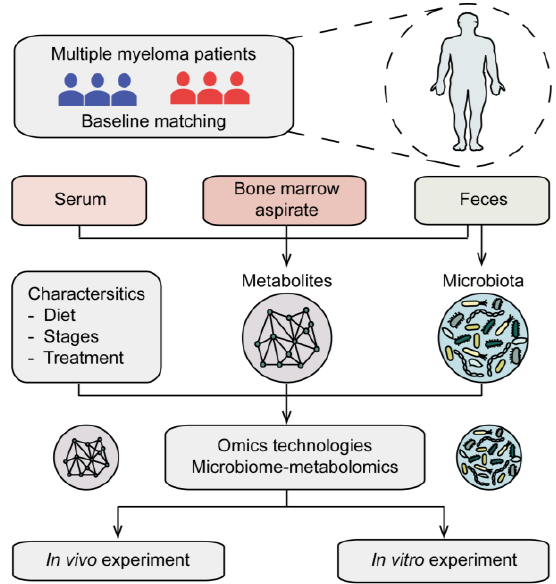
Figure 2. Application of microbiome/metabolomics in multiple myeloma. Eligible MM cohorts with matched baselines are recruited for sampling, then collected along with clinical characteristics for further analysis. Samples of serum, bone marrow aspirate and feces are performed with metabolomics, while paired fecal samples are utilized for microbiome sequencing. Furthermore, an analysis of differential metabolites and microbiota associated with MM is conducted, and then, in vivo and in vitro experiments are performed for further verification and mechanistic study.